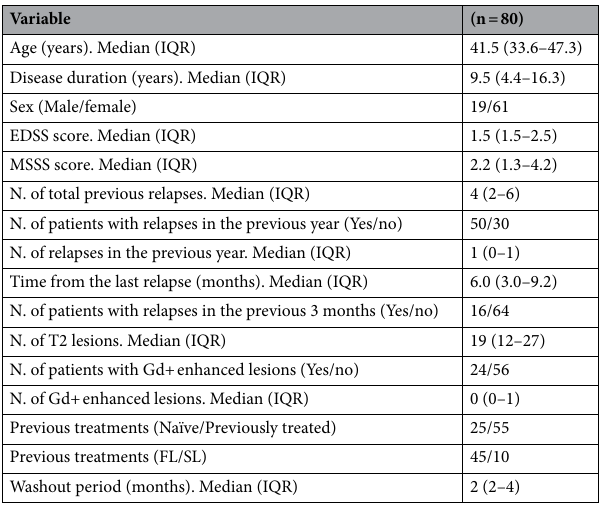
Table 1. Baseline clinical and demographic data of patients included in the study. EDSS Expanded Disability Status Scale, Gd gadolinium, FL first line drugs, IQR interquartile range, MSSS Multiple Sclerosis Severity Score, N. number, SL second line drugs.